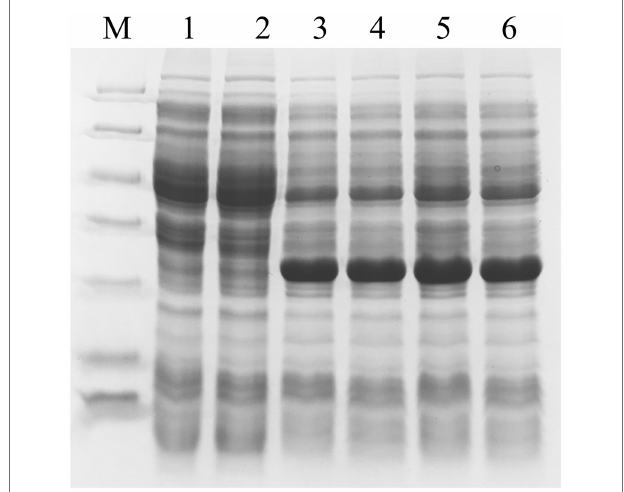
FIGURE 6 | Determination of the expression of recombinant eGFP in E. coli BL21 (DE3) by SDS-PAGE. The total cell extract and soluble cell extract from induced E . coli BL21 (DE3). Lane M, protein molecular mass standards (Unstained Protein Molecular Weight Marker, No. 26610, Thermo Fisher Scientific, Waltham, MA, United States); lane 1, total BL21 (DE3)/pET-28a (+), lane 2, soluble BL21 (DE3)/pET-28a (+), lane 3, total BL21 (DE3)/pET-28a-